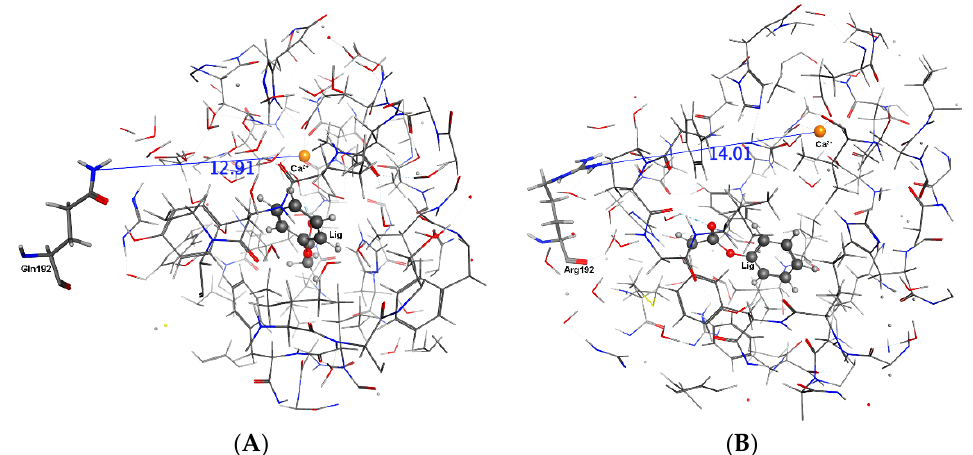
Figure 6. The distance between residue192 and Ca 2+ ion in the active site of the Phenylacetate complex after 20 ns. ( A ) is the QPON1. ( B ) is the RPON1. Table 6. The average distances (A) between Arg/Gln192—Ca 2+ , His115—Ca 2+ in QPON1, and RPON1 Isoenzymes over 20 ns.